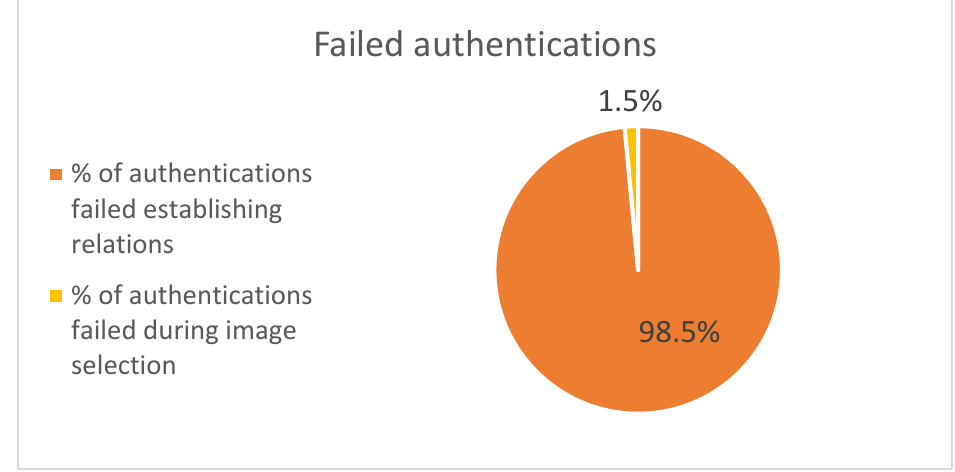
Figure 9. Failed authentication attempts information.